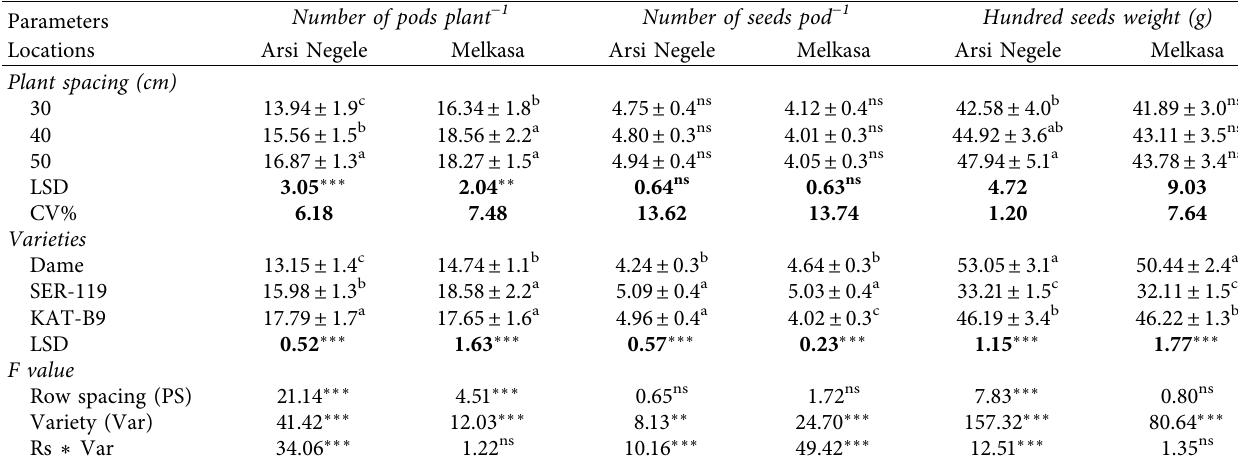
Table 4: Efect of interrow spacing on number of pods plant − 1 and number of seeds pods − 1 of common bean varieties at the Arsi Negele and Melkasa